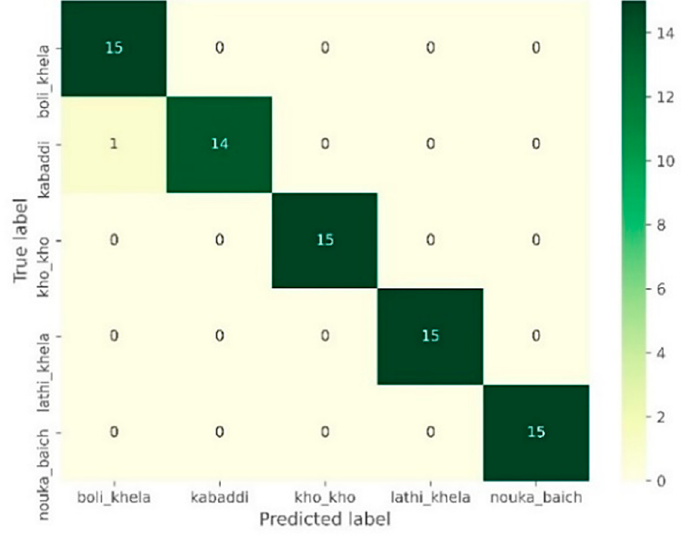
Figure 10. Confusion matrix for Model